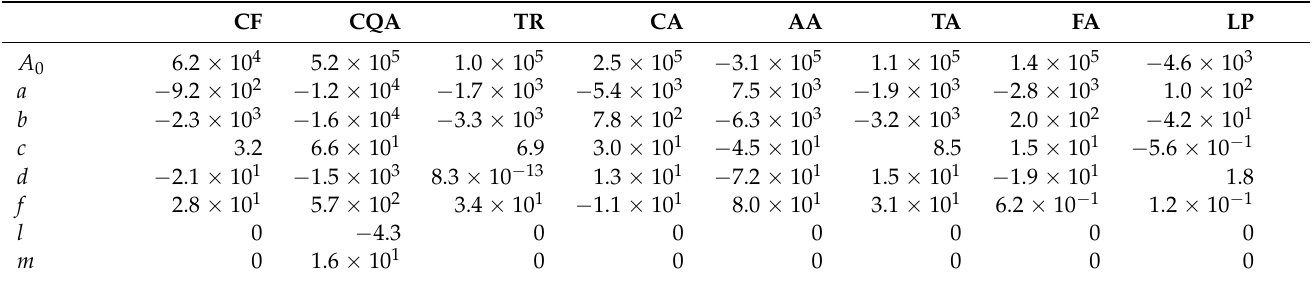
, k = CF, CQA, TR, CA, AA, TA, FA, LP, for the k